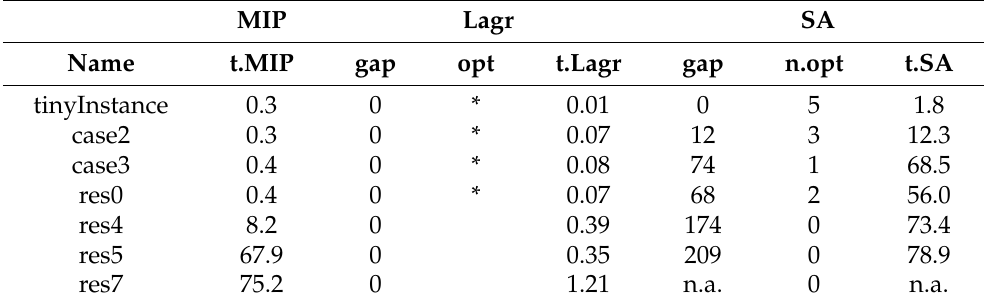
Table 2. Results using the Lagrangian metaheuristic; an asterisk indicates that the heuristic itself was able to prove the optimality of the obtained